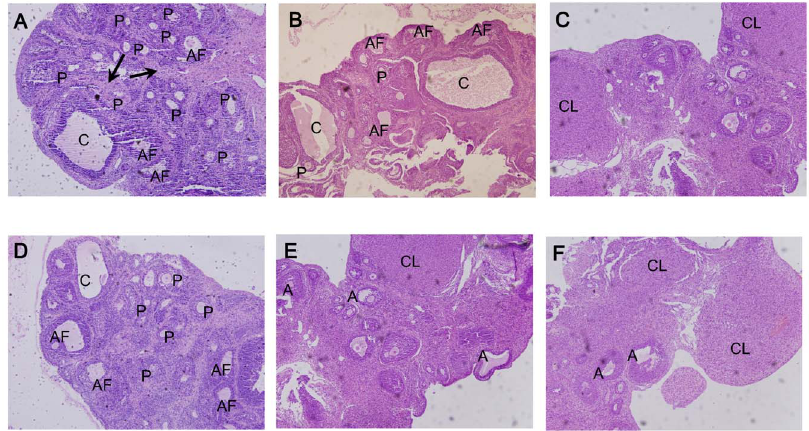
Figure 3. Ovarian morphology of rats from three groups ( 6 100). A : PF . A lot of preantral follicles (P) and atretic follicles (AF) with enlargement of stroma (arrow) and cystic follicles (C) are shown in the section. B : PO . A lot of preantral follicles (P), atretic follicles (AF) and cystic follicles(C) are shown in the section. C : CO . Various stages of development follicles and some corpora lutea (CL) are shown. D : PF-SF . A lot of preantral follicles (P) and atretic follicles (AF), and cystic follicles(C) are shown in the section. E : PF-EF . A lot of antral follicles (A) and a bit of corpora lutea (CL) are shown in the section. F : PF-EO . A lot of antral follicles (A) and a bit of corpora lutea (CL) are shown in the section. doi:10.1371/journal.pone.0099155.g003 PLOS ONE |